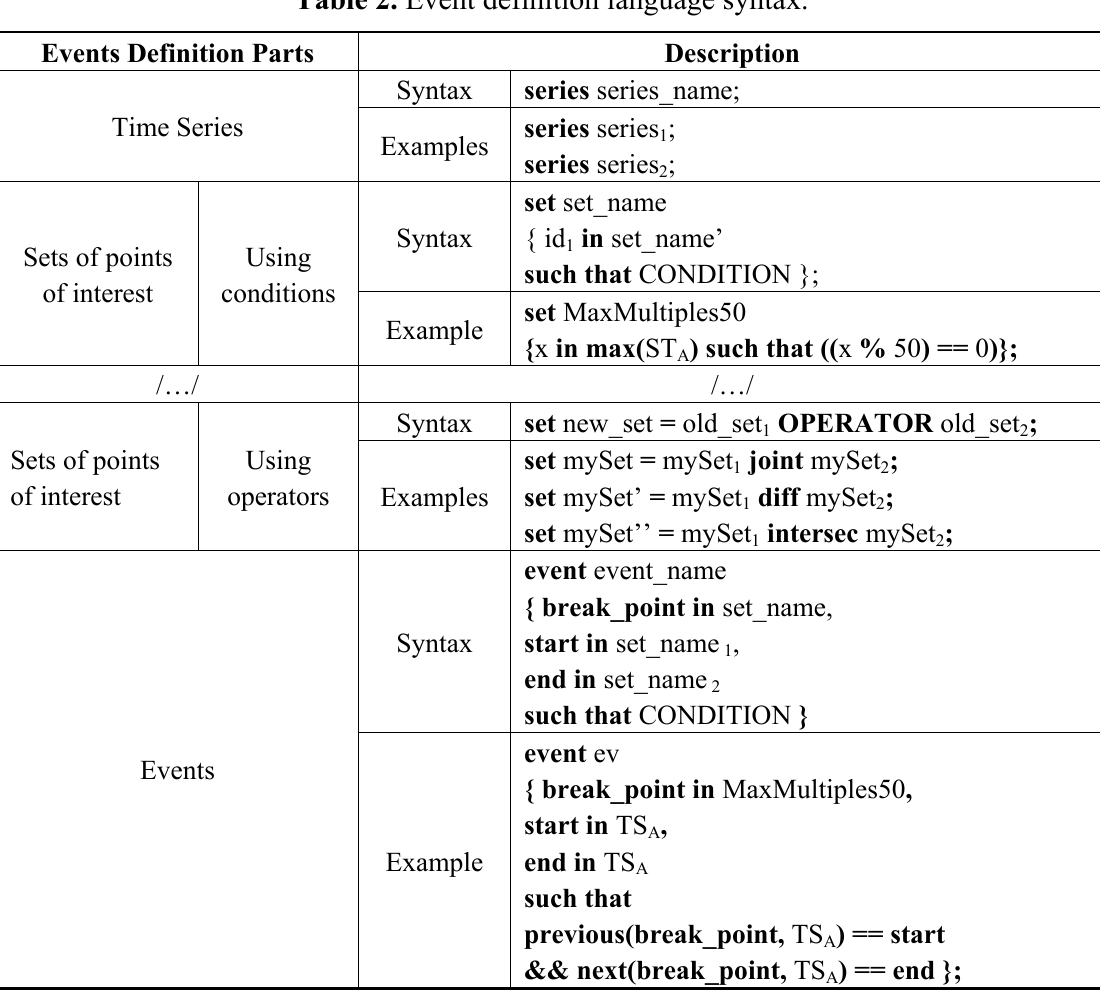
Table 2. Event definition language